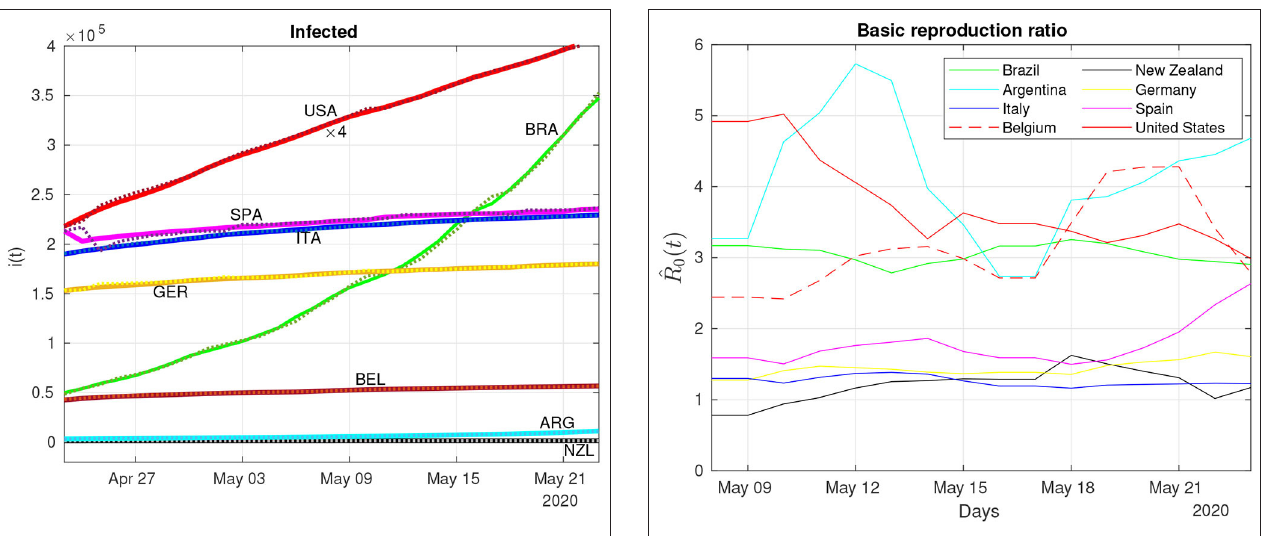
FIGURE 6 | Daily monitoring of the COVID-19 pandemic: Dynamic behavior of the estimated reproduction number for 2 weeks in May 2020.